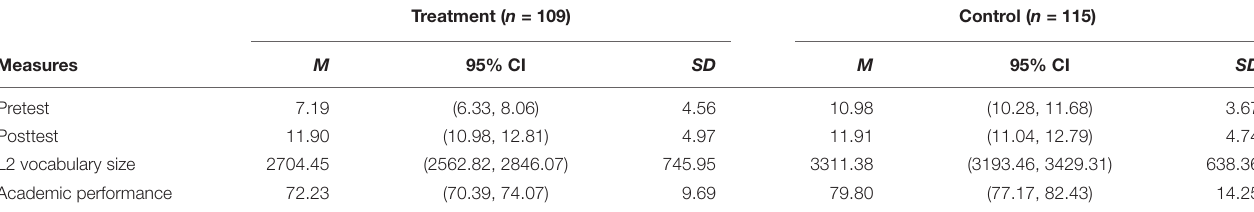
TABLE 5 | Descriptive statistics for reading tests, L2 vocabulary size, and academic